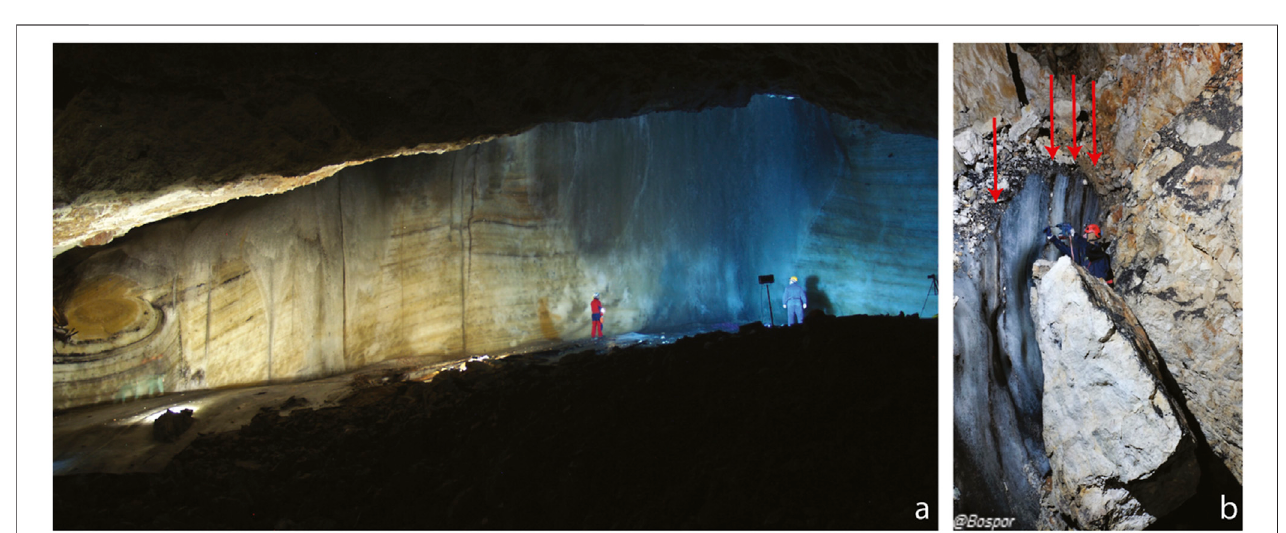
FIGURE 2 | Example of post-depositional modi fi cations of ice layering. (A) The ice wall in the Little Reserve, Sc ă ri ș oara Ice Cave, Romania. Individual layers have differentdegreesofinclination,makingcoresdrilledindifferentsectionoftheiceblockintersectinglayersofdifferentageatthesamedepth.Newlyformedicecoverspart oftheoldiceinthecenter-left(blueicebetweenthetwocavers). (B) Icelayerstiltedtonearvertical(indicatedbytheredarrows)inCrnaLedenicaCave,Croatia(photoby Ž eljko Marun č i ć Bospor).